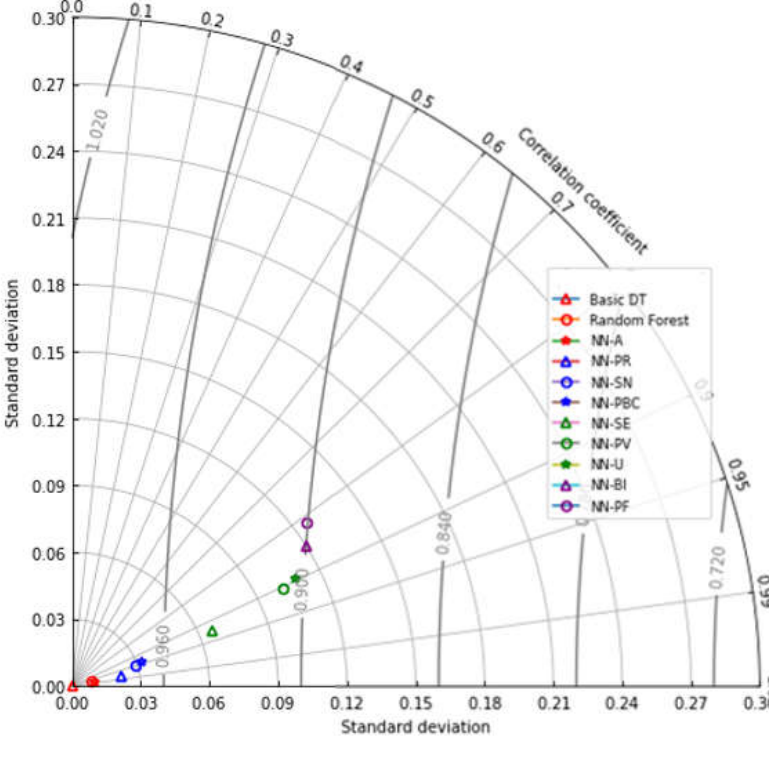
Figure 6. Taylor Diagram.